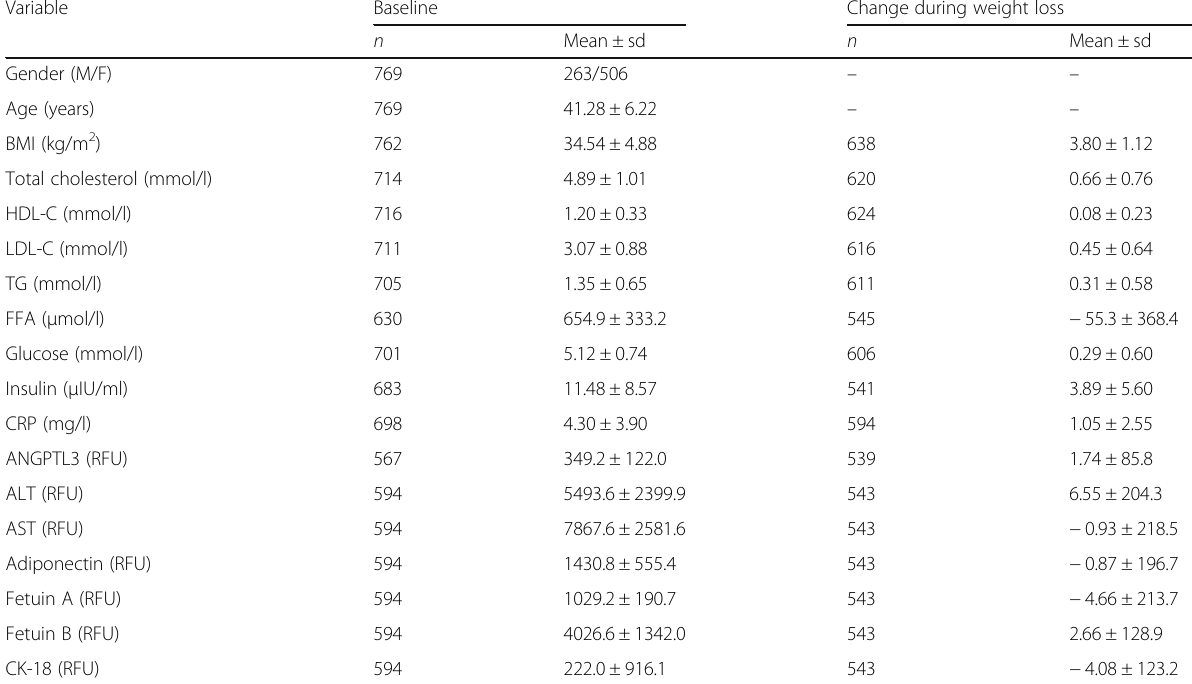
Table 1 Participant